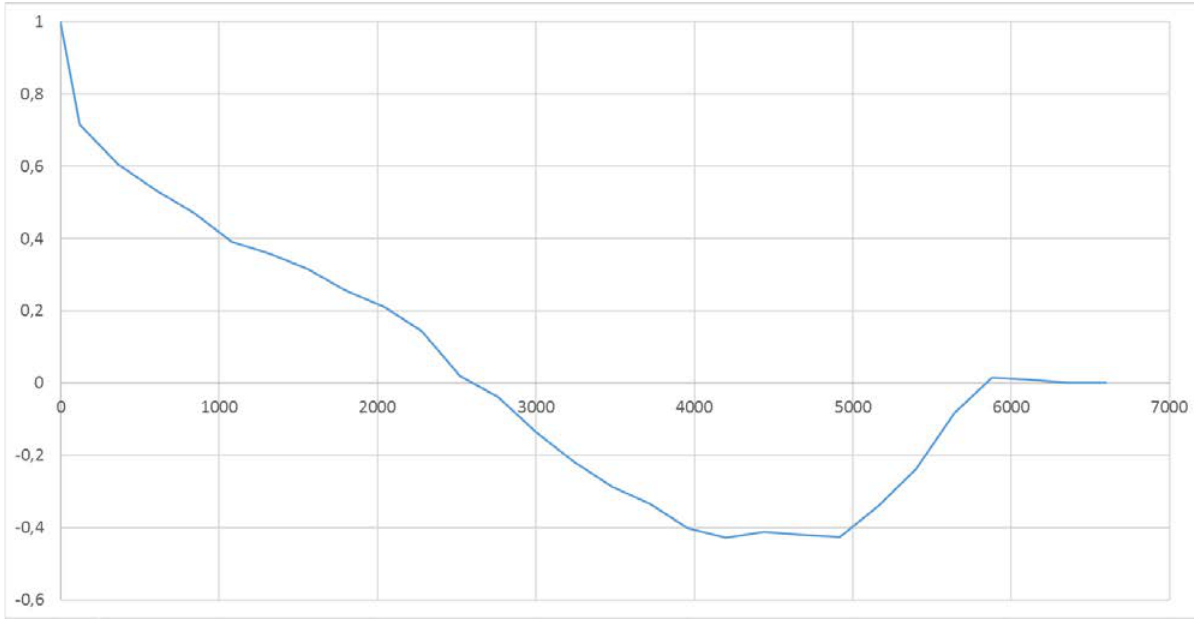
Figure 1. Example of EAF, which corresponds to a phase image (before atmospheric correction) with L_corr equal to 720